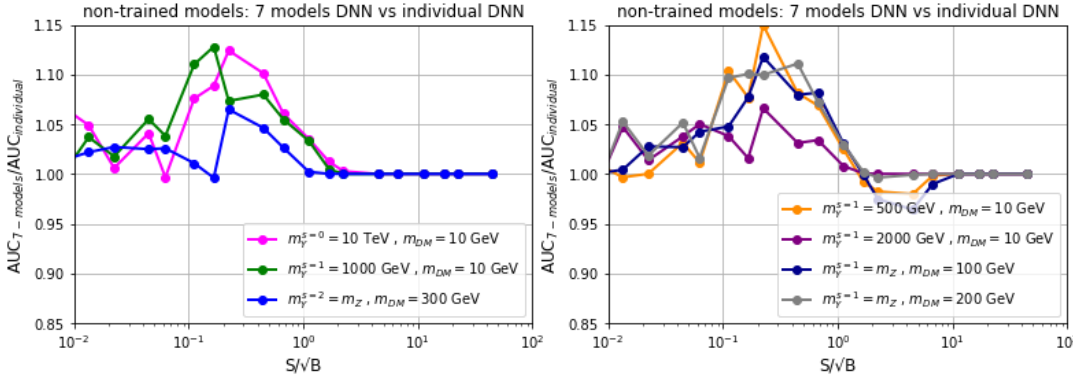
Figure 15: Same as in Fig. 14, but in this case test samples are generated with dif- ferent models from those the network was trained